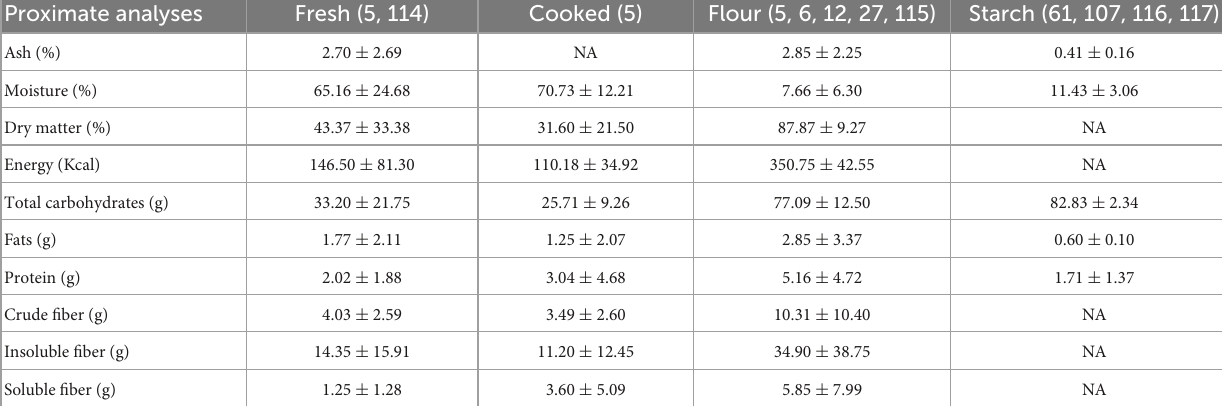
TABLE 1 Mean reported values for breadfruit ( Artocarpus altilis and hybrids) proximate analyses per 100 g